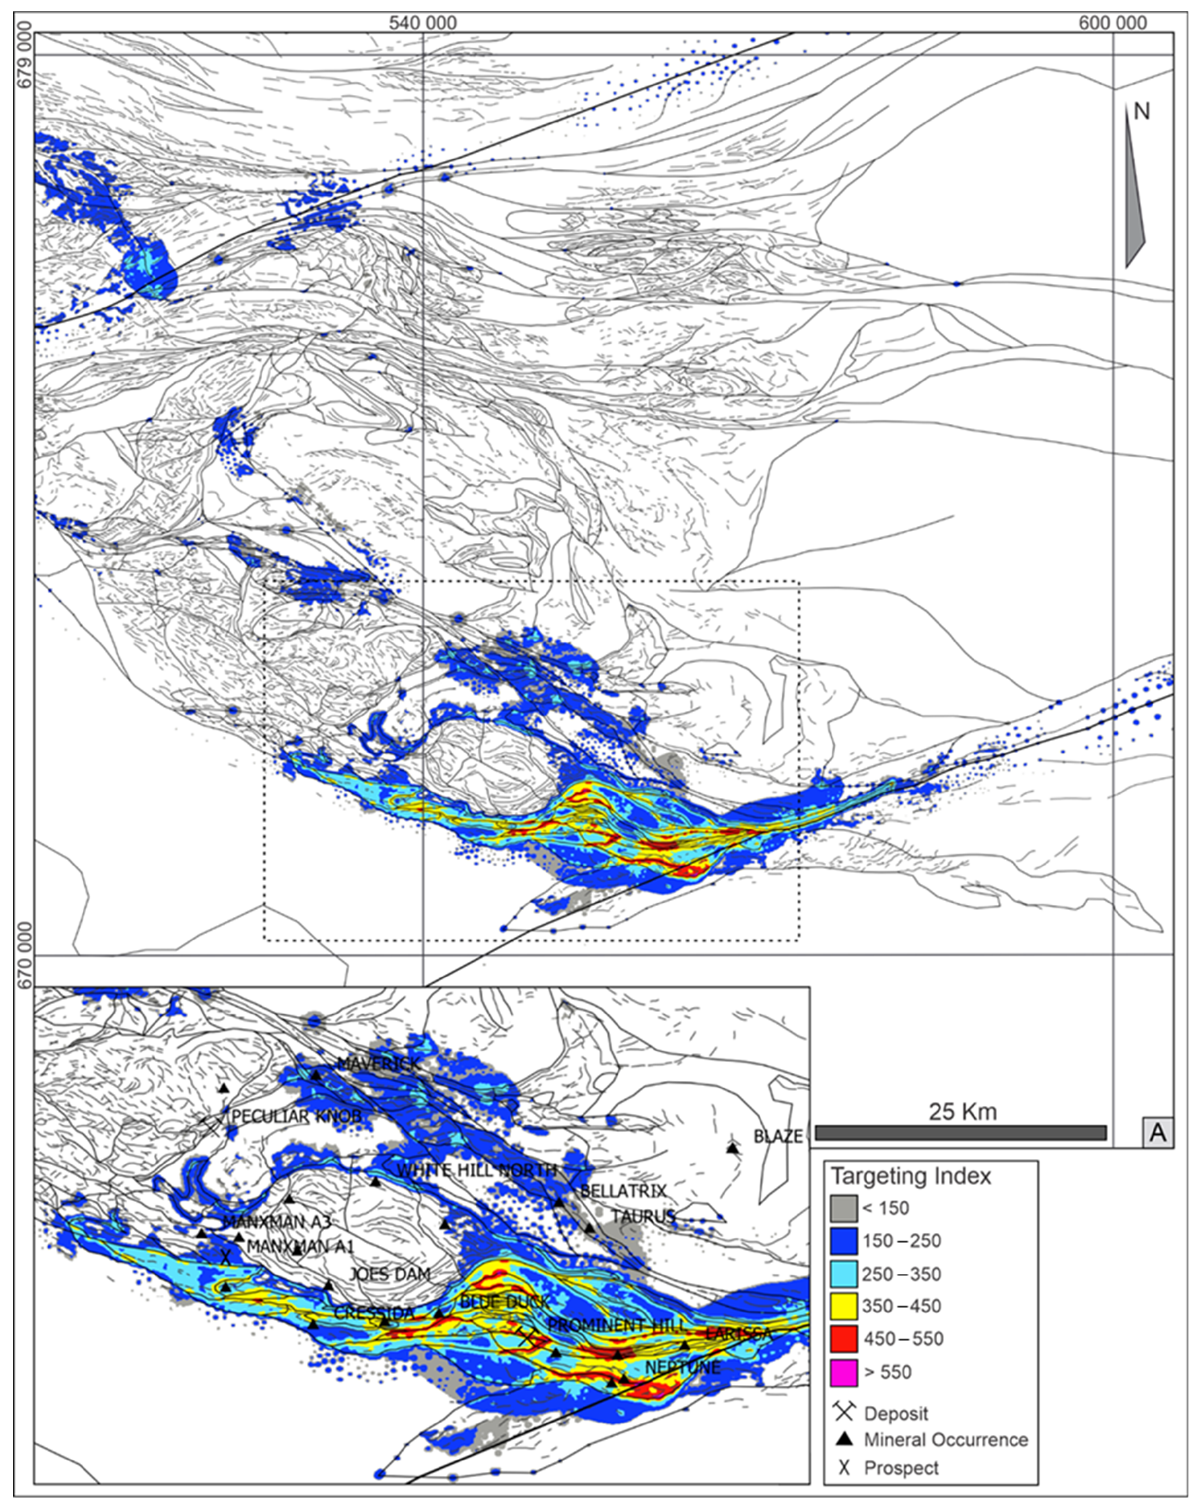
Figure 12. Integrated target index or heat map of IOCG prospectivity across: ( A ) the Mt. Woods Inlier and ( B ) across the Prominent Hill region (inset). Areas of high IOCG prospectivity (warmer colours) coincide with known IOCG-related occurrences, prospects and deposits and include: Prominent Hill, Prominent Hill West, Blue Duck, Neptune, Proteus, Triton and Larissa.